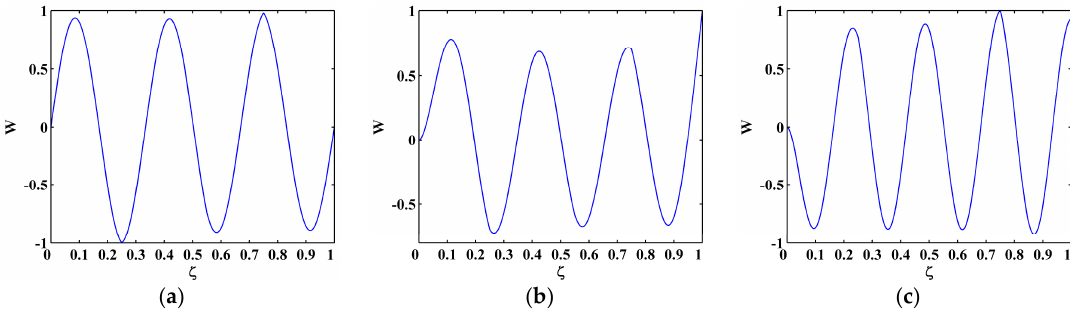
Figure 3. ( a ) Sixth; ( b ) seventh; and ( c ) eighth mode shapes of SS-SS, C-F, and C-FS beams. Materials 2017 , 10 , 656